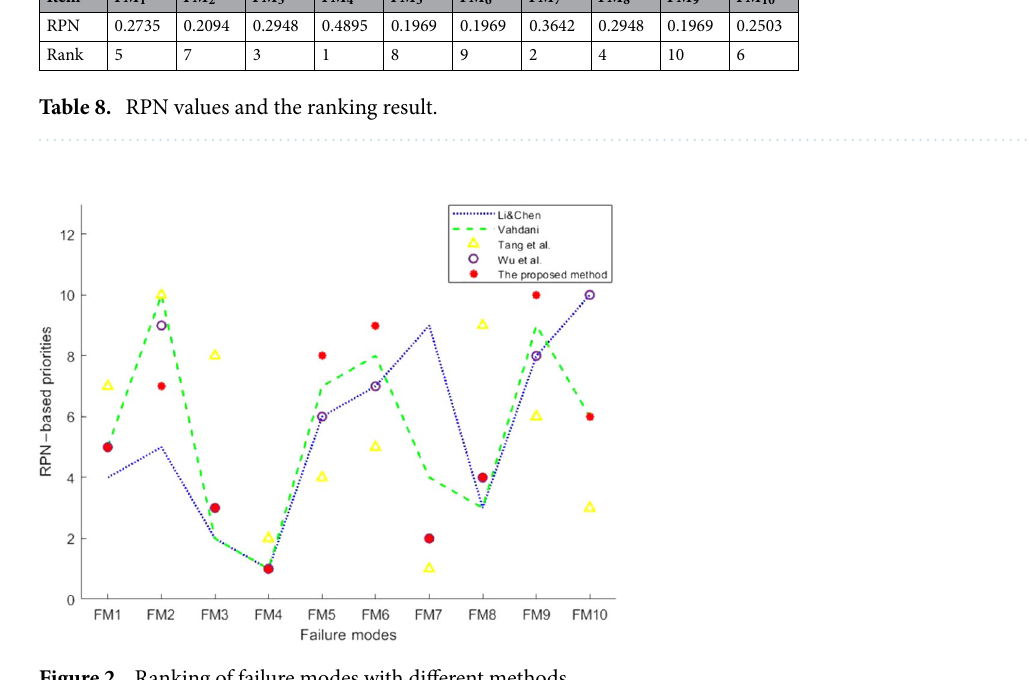
Figure 2. Ranking of failure modes with different